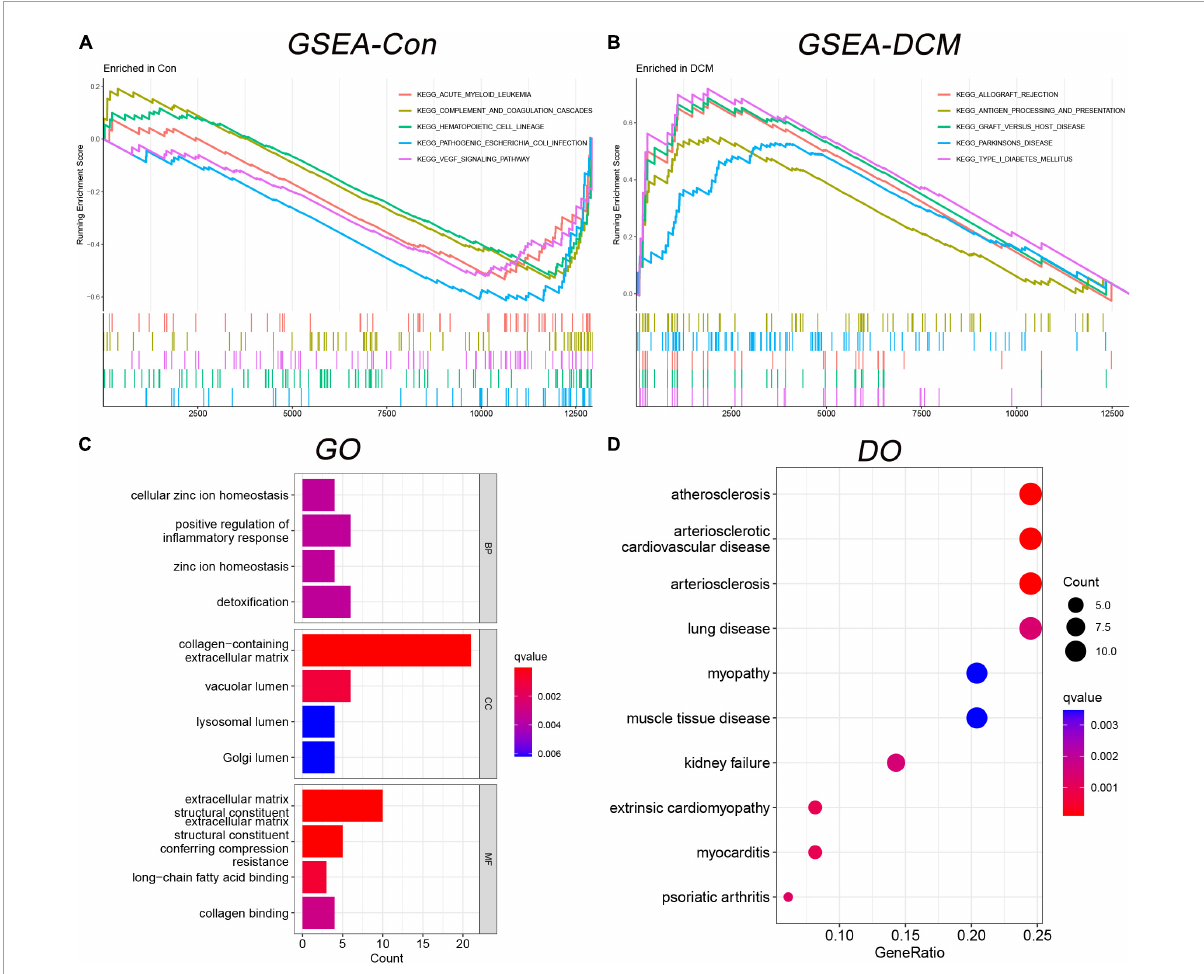
FIGURE3 Functional enrichment analysis in gene set enrichment analysis-kyoto encyclopedia of genes and genomes (GSEA-KEGG), gene ontology (GO), and disease ontology (DO). (A) The GSEA-KEGG enrichment in control; (B) the GSEA-KEGG enrichment in DCM; (C) the GO enrichment term; and (D) the DO enrichment